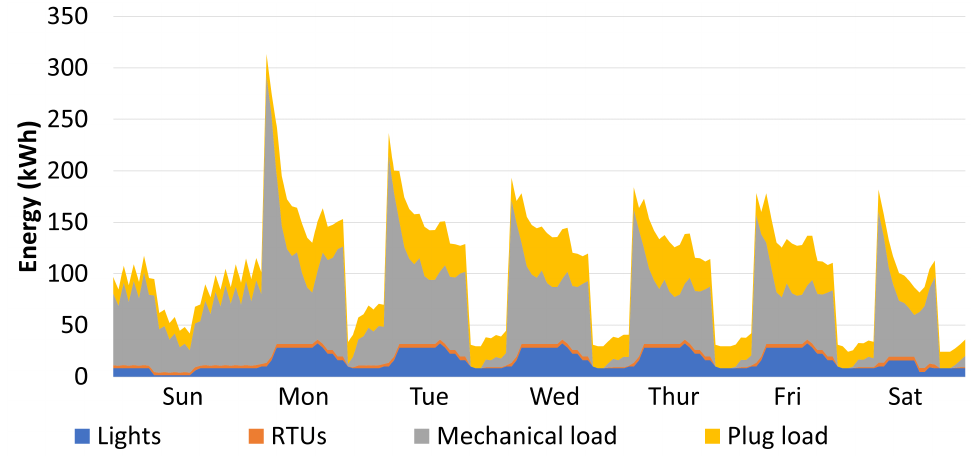
Figure 7. Hourly load profile of different building components for a week in January.